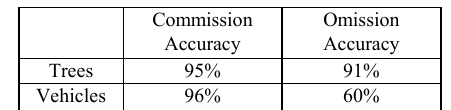
Table 2: classification performance for dataset Vaihingen